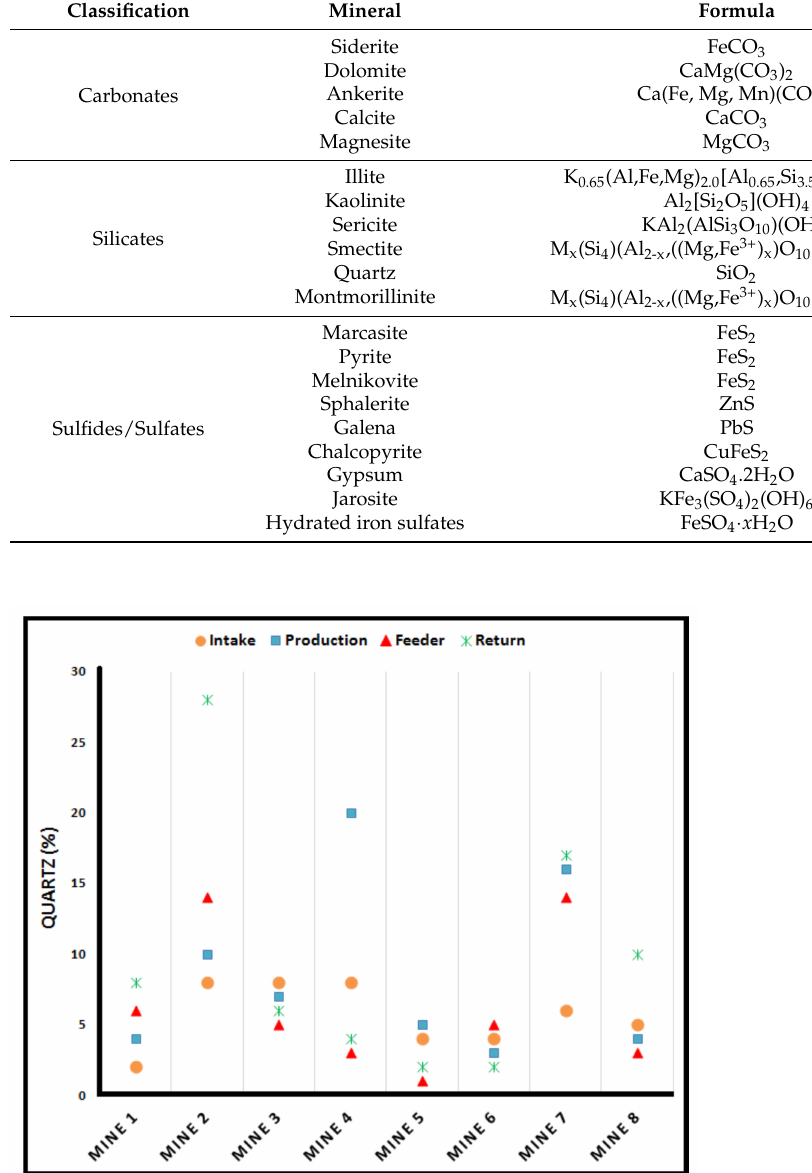
Figure 6. Average quartz distributions (% of characterized particles) with different loca- tions/operations in mid-central Appalachia (Mines #1–4), northern Appalachia (Mines #5–6), and south-central Appalachia (Mines #7–8)